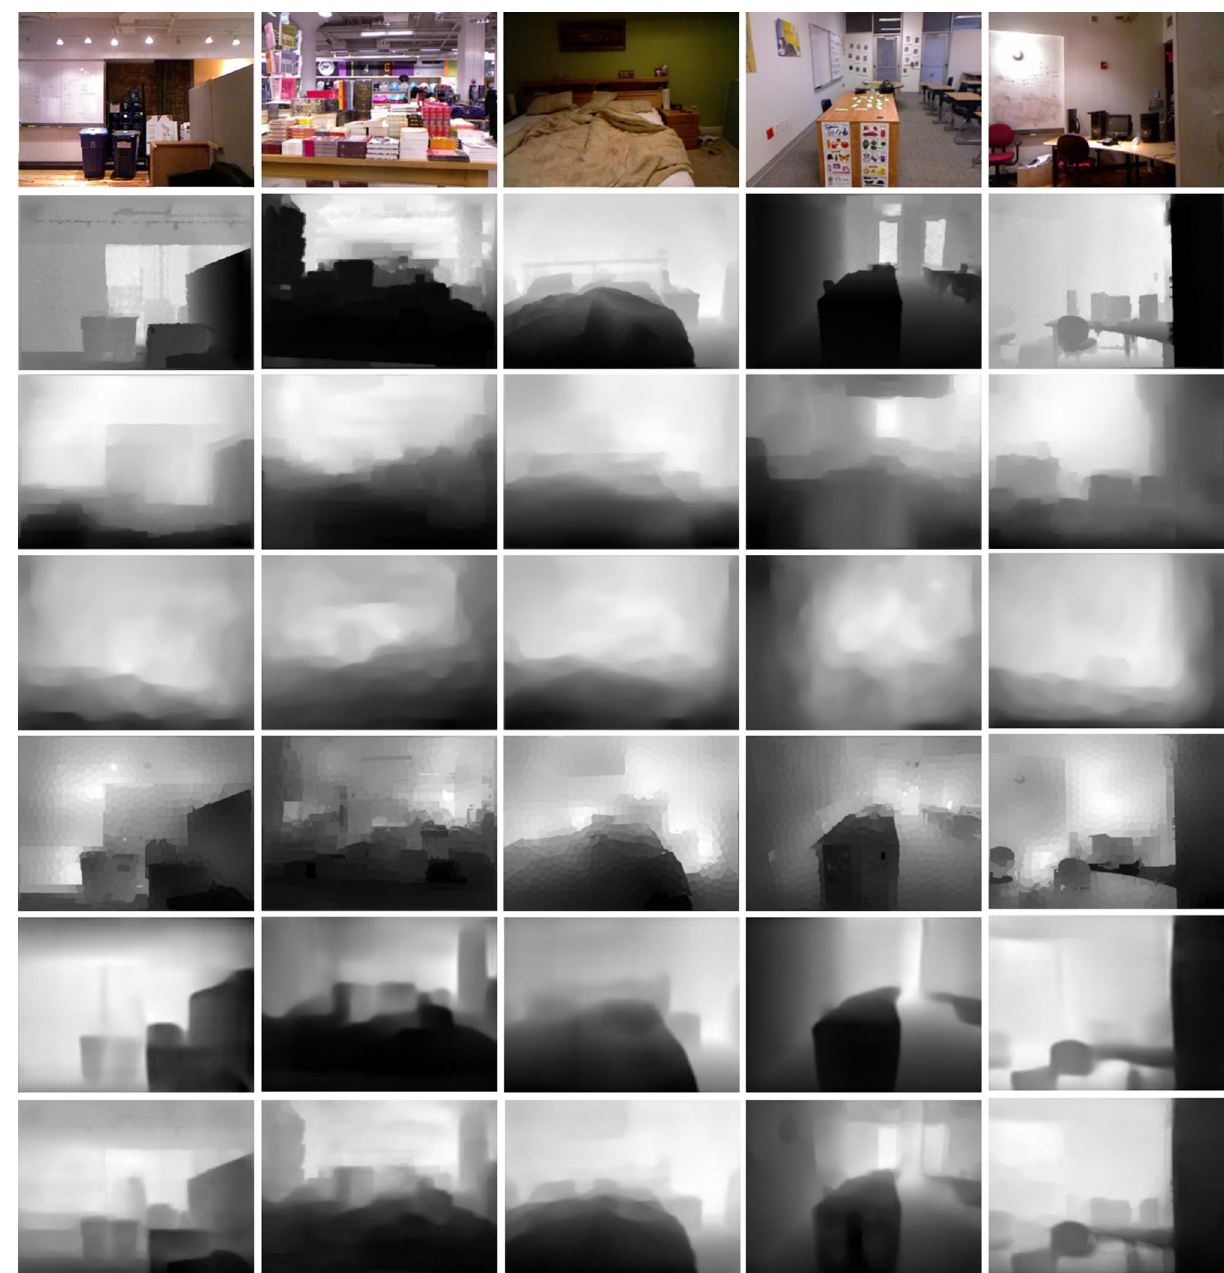
Fig. 4 Experimental results on NYUv2 dataset. First row: the input image, second row: the ground truth, third row: DT [11], fourth row: DA [12], fifth row: DCNF [22], sixth row: FCRN [23] and last row: the proposed